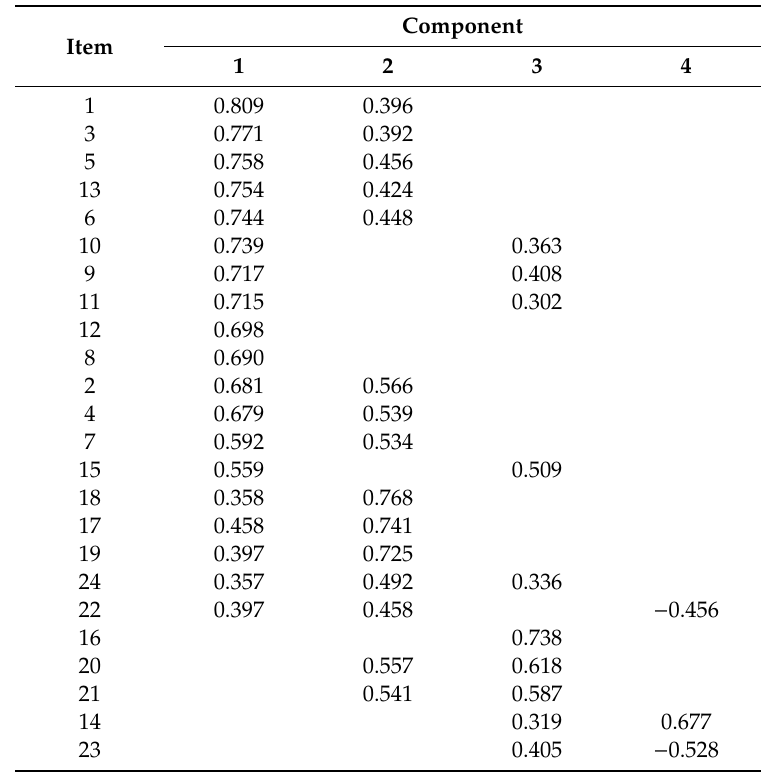
Table 3. Exploratory factorial analysis considering the principal components method with orthogonal rotation (varimax method with Kaiser